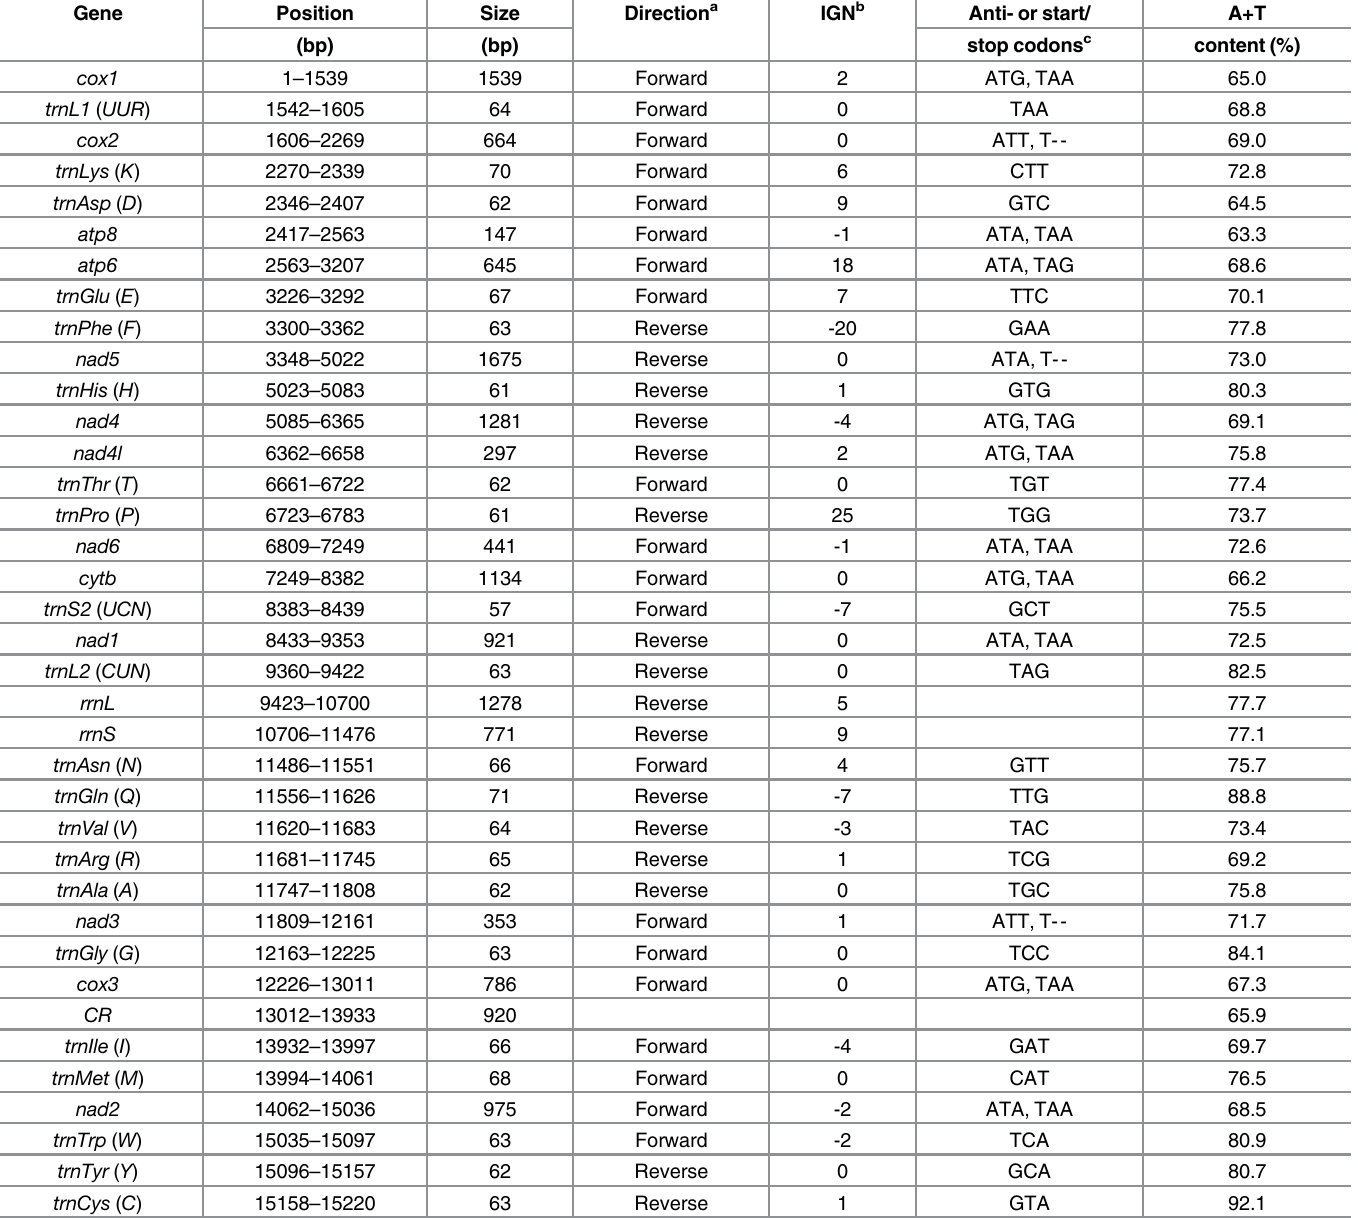
Table 1. Gene structure of the mitogenome of Aleurocanthus spiniferus